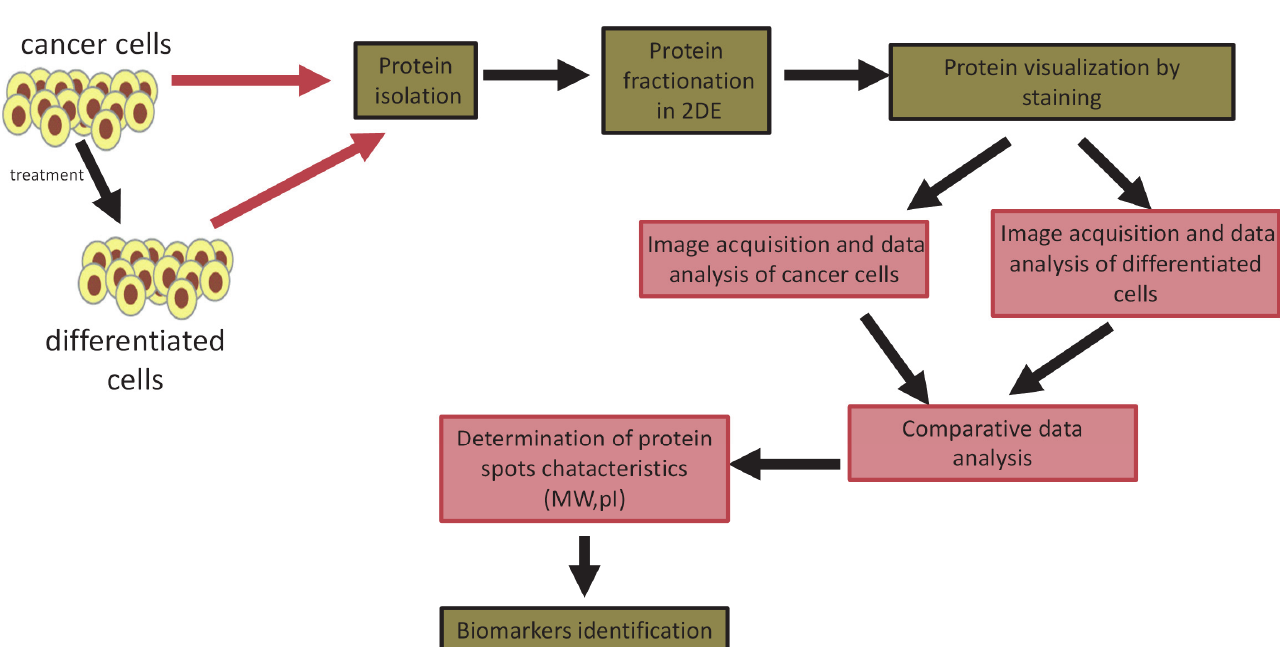
Fig. 5. Result of image bar selection and identification of protein standard MW markers in 2DE gel